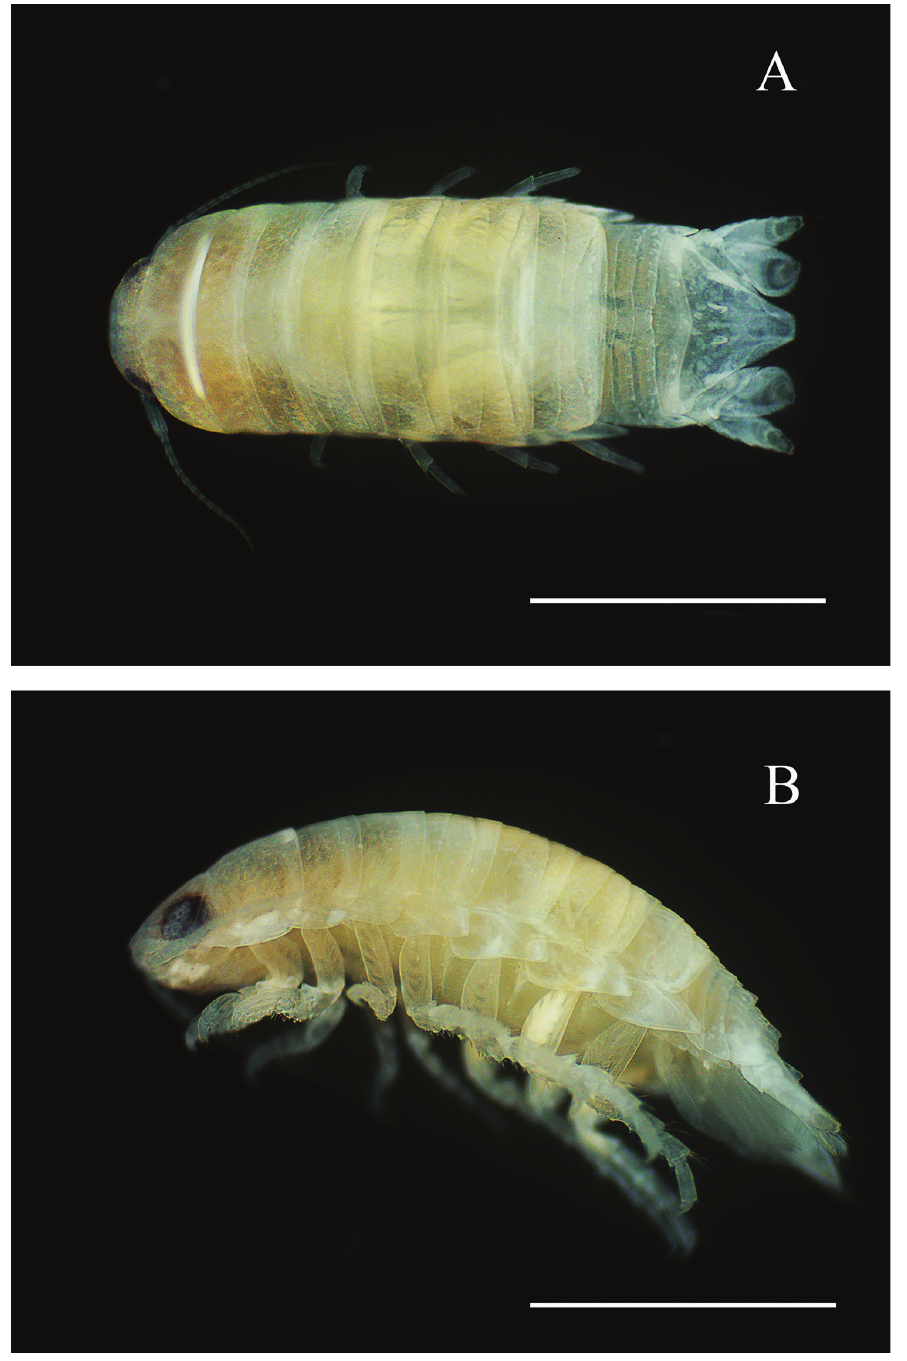
Figure 7. Cirolana phuketensis sp. n. male holotype, (PSUZC–CR0286-01) (5.0mm) A dorsal view B lateral view. Scale bar: 2